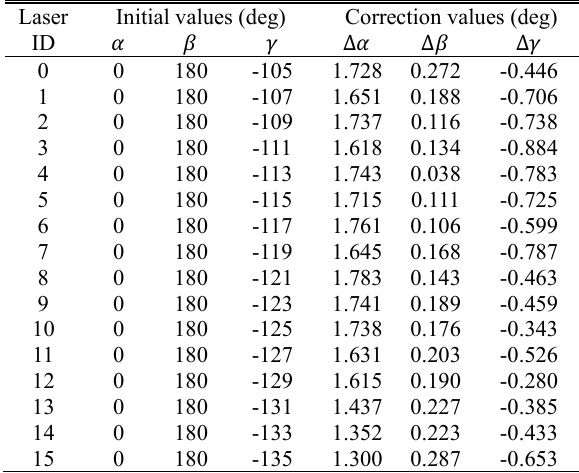
Table 1. Initial laser-IMU boresight angles and the corrections.